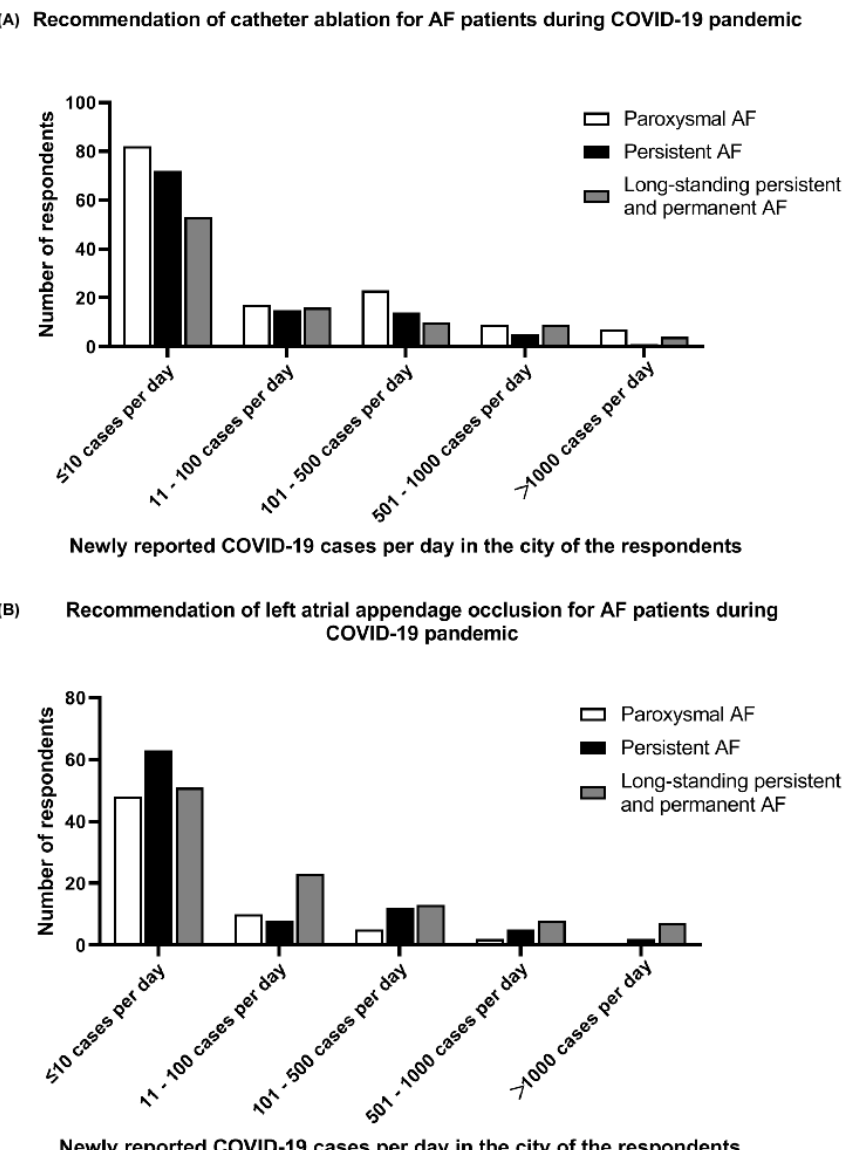
Figure 4. Invasive interventional therapies recommended by the participating cardiologists for AF patients during the COVID-19 pandemic. ( A ) Recommendation of catheter ablation for AF patients during COVID-19 pandemic. ( B ) Recommendation of left atrial appendage occlusion for AF patients during COVID-19 pandemic.